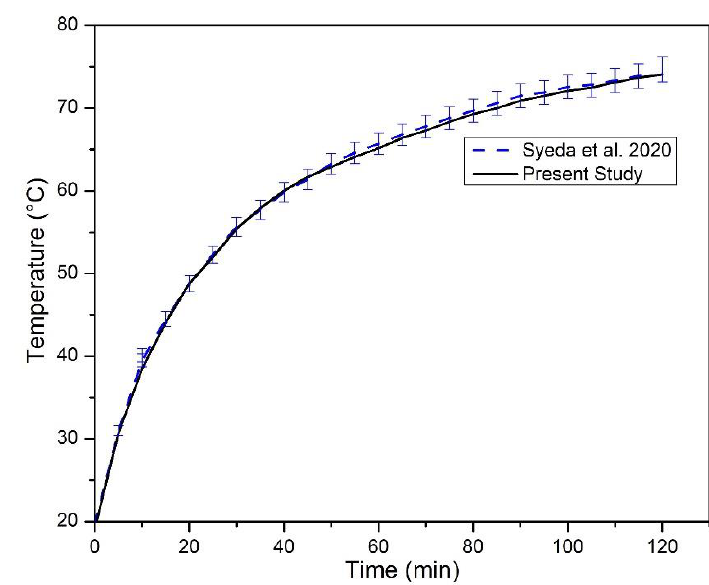
Figure 6. Test setup validation to investigate HS performance.